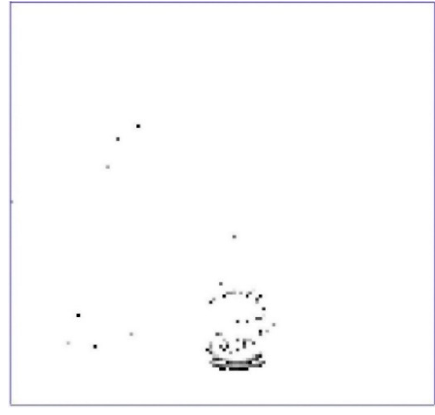
Figure 2. DVS recording of a ping-pong ball passing.